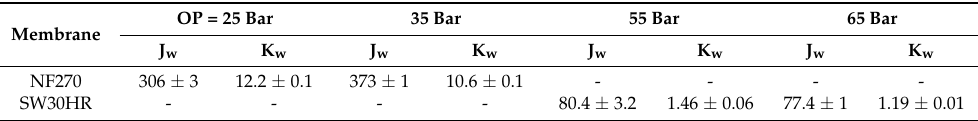
Table 5. Measured pure water fluxes, J w (in L · m − 2 · h − 1 ) and permeabilities, K w (in L · m − 2 · h − 1 · bar − 1 ) of the membranes at different operating